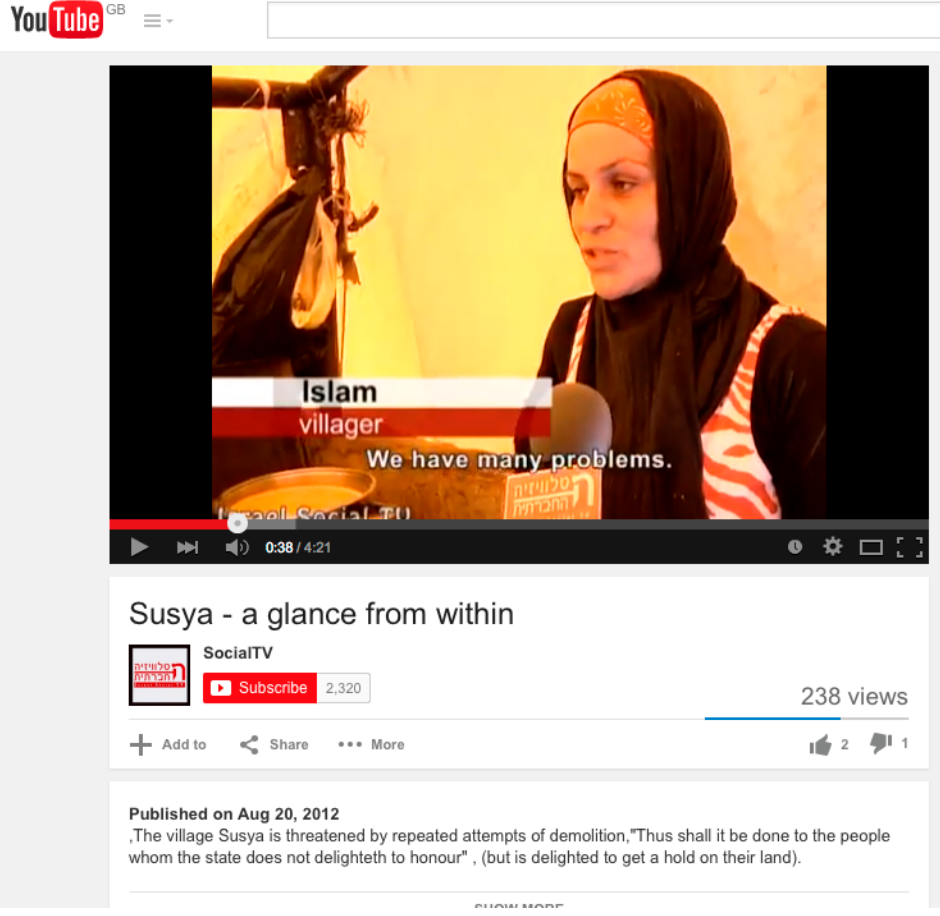
Figure 12. Screen grab from Social TV’s feature on Susiya—‘A Glance from Within’. (Accessed on 14 September